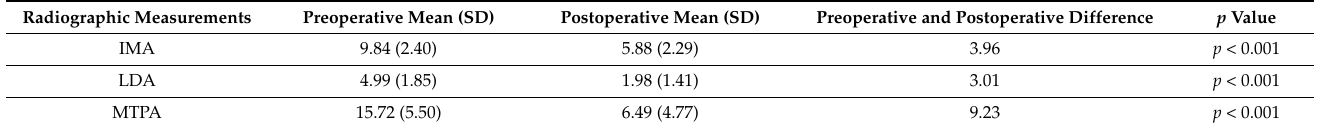
Table 2. Results of the pre- and postoperative radiographic measurement.